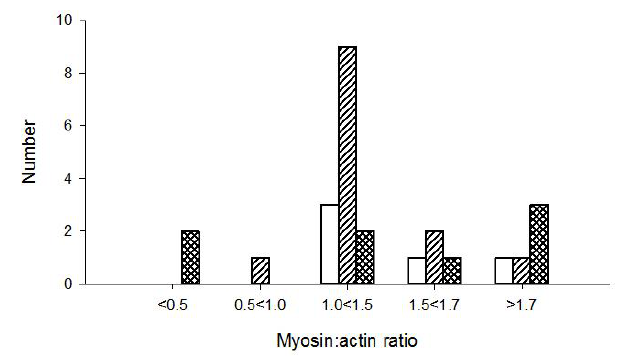
Figure 5. Patients diagnosed as critical illness polyneuropathy (CIP; open bar), normal (diagonal bar), and CIM (hatched bar) based on direct vs. indirect stimulation in patients with different myosin:actin ratios. Figure 4. Diagnosis of critical illness myopathy (CIM) based on myosin loss determined from enzyme histochemical and immunocytochemically stained muscle biopsy cross-sections from ICU patients. Open bars represent no CIM, grey bars indicate suspect CIM and diagonal bars represent CIM. The myosin:actin ratios measured in biopsies from the same occasion and muscle are presented in a total of 51 patients in groups separated into severe (<0.5), high (0.5–<1.0), moderate (1.0–<1.5) to small (1.5– <1.7) preferential myosin loss as well as in patients with normal M:A ratios (>1.7).